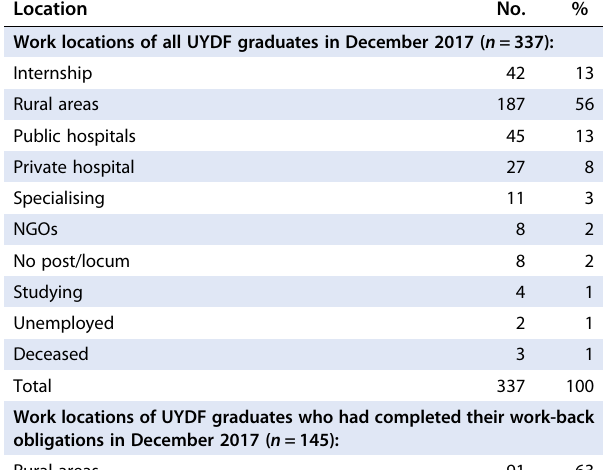
Table 2: Participants ’ demographic characteristics ( n = 40) Characteristic